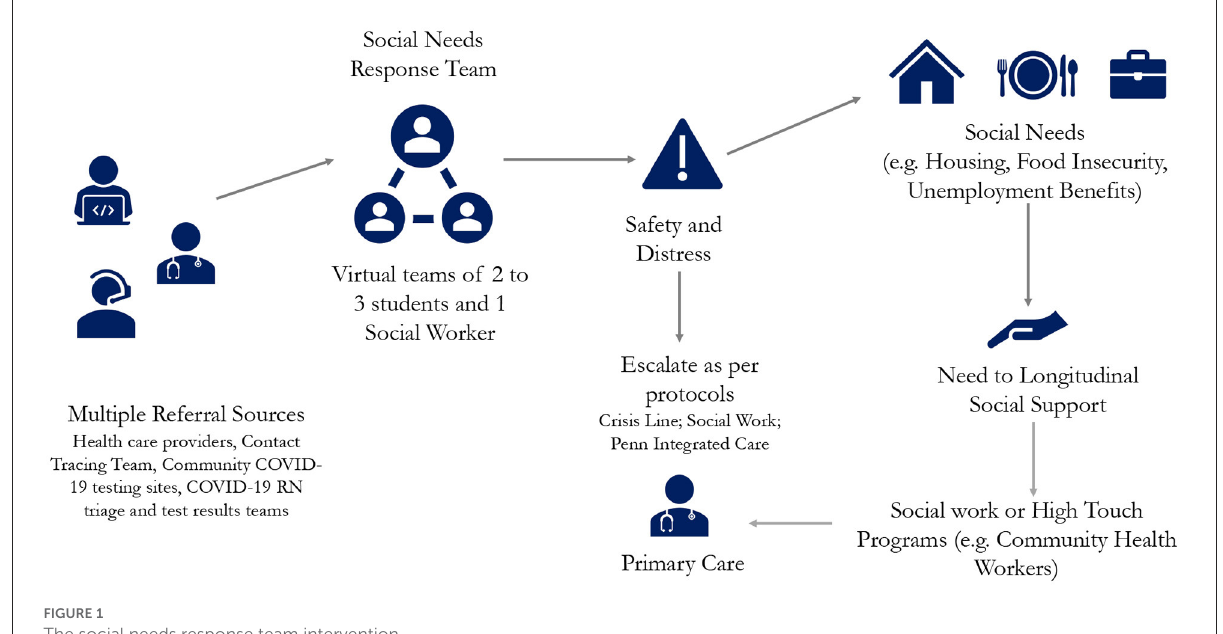
FIGURE1 The social needs response team